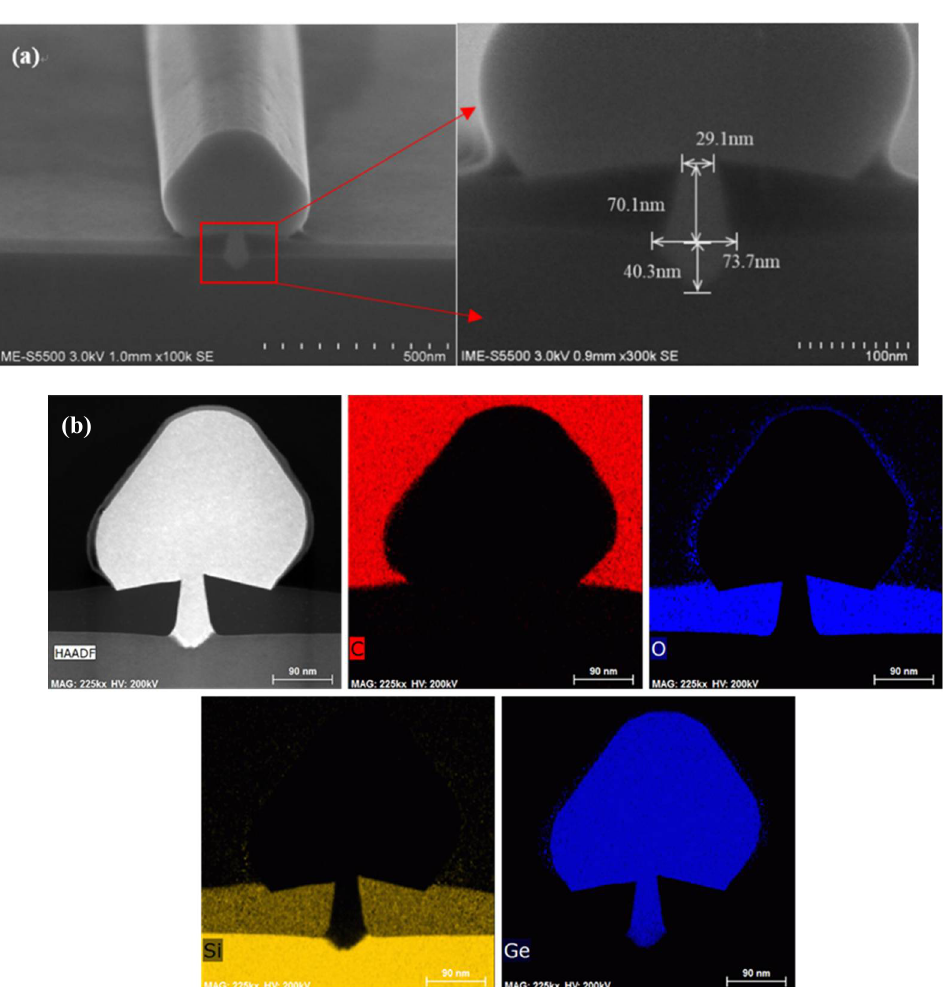
Figure 8. ( a ) Cross-sectional SEM image of the Ge-fin structure; ( b ) EDS mappings of the Ge filling in STI with elements of C, O, Si and Ge in order.